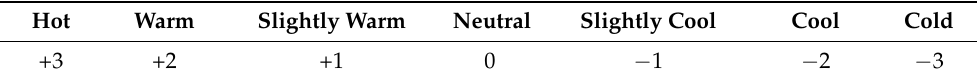
Table 5. Seven-point thermal sensation scale.